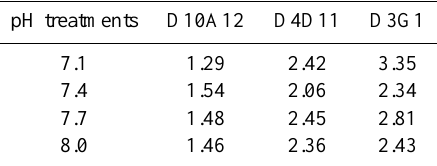
Table 1. The Q 10 values (1–8 ◦ C) for D10A12, D4D11 and D3G1 strains were calculated according to Eq. (2), based on the mean maximum growth rates displayed in Supplement Tables S2 and